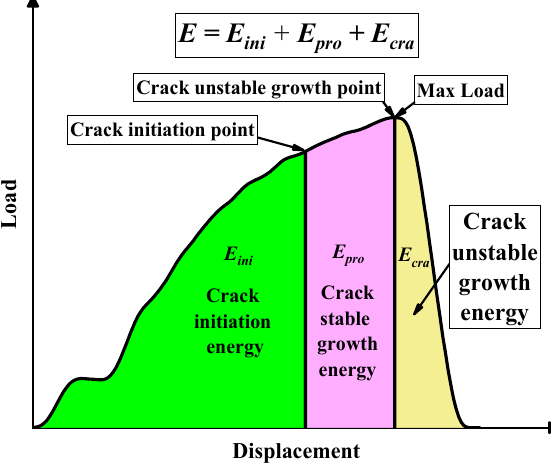
Figure 14. Schematic diagram of the impact energy division.